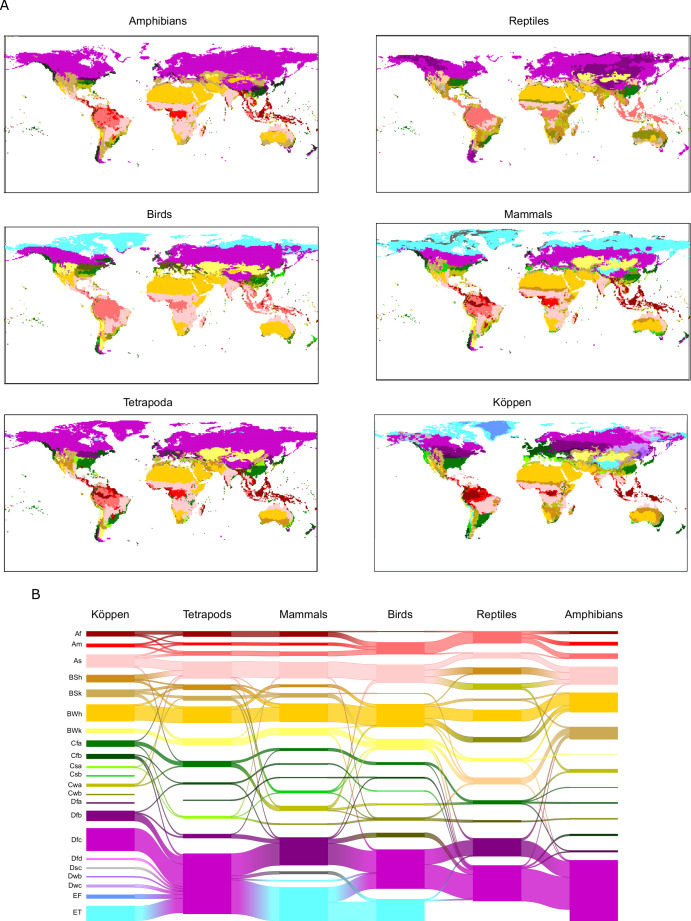
Tetrapod groups and Köppen’s climatic regions.(A) Geographic location of tetrapods’ niche domains and Köppen’s climatic regions. (B) Alluvial diagram comparing the climatic regions between classifications. In the stacks of boxes, one for each classification, a box represents a climatic region, and the height of the box is proportional to the number of raster cells of the climatic region. Streamlines connecting boxes in different stacks depict the number of raster cells shared between climatic regions of different classifications. Colors according to Figure 2.